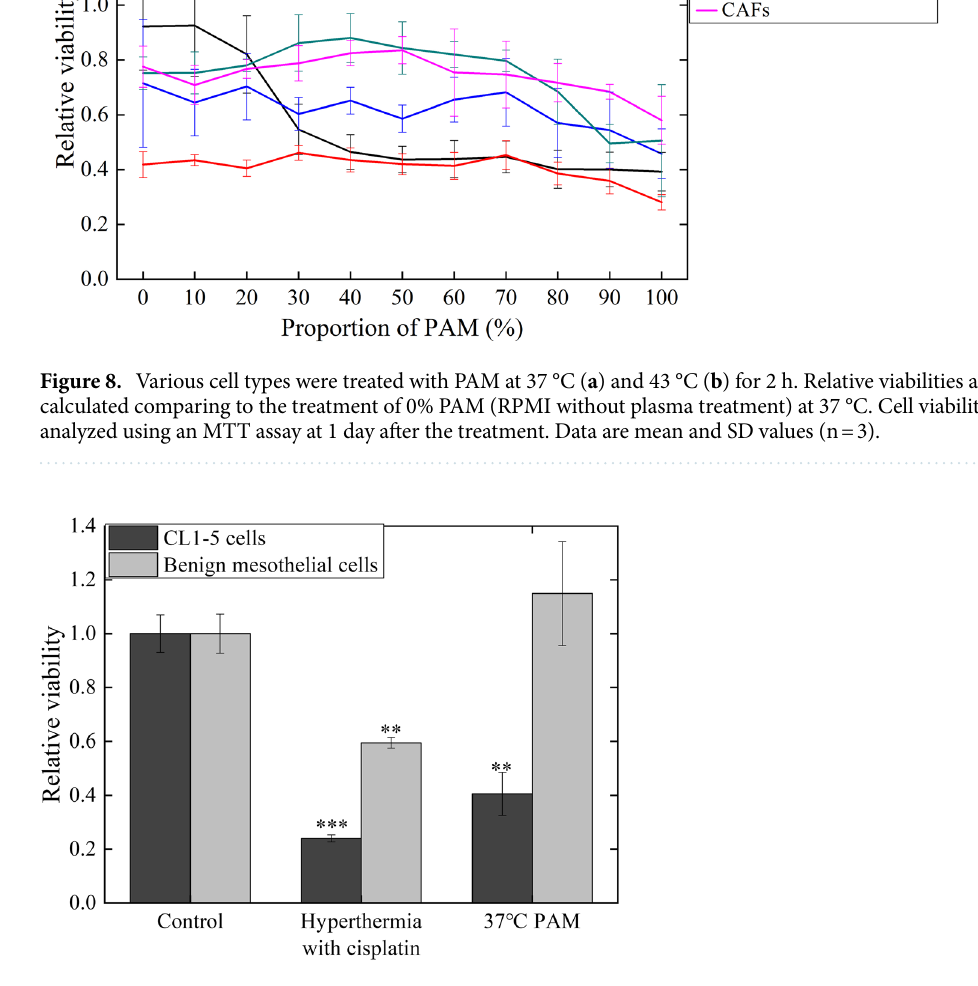
Figure 9. CL1–5 and benign mesothelial cells were treated with 100% PAM at 37 °C or saline with 200 mg/m 2 cisplatin at 43 °C for 2 h. An MTT assay was performed to determine the cell viability. Data are mean and SD values (n = 3). * P < 0.05; ** P < 0.01; *** P < 0.001 (Student’s t